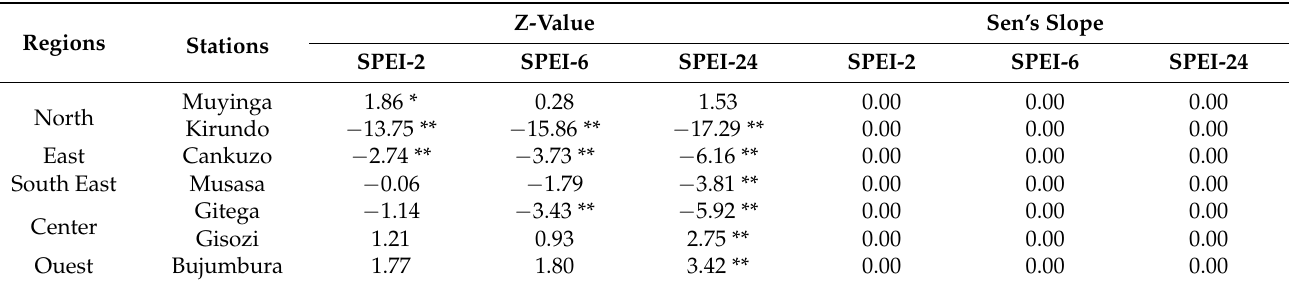
Table 4. The results of the Mann–Kendall (MK) trend test and Sen’s slope for SPEI index values at 2, 6, and 24 month timescales. * significant and ** highly